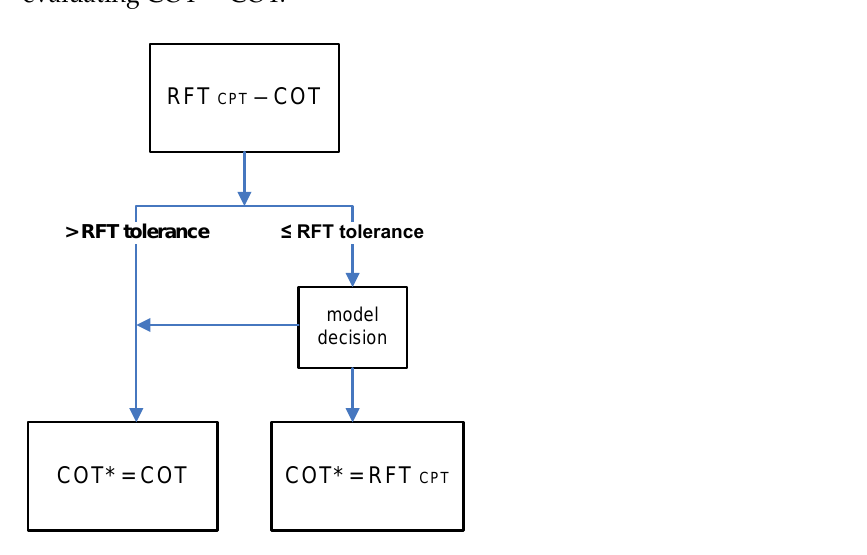
Figure 6. Representation of the CMP residual flight time relaxation decision